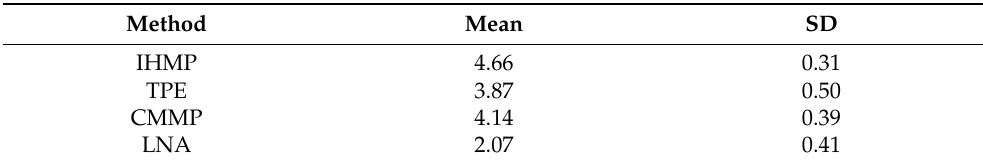
Table 7. The scores of different